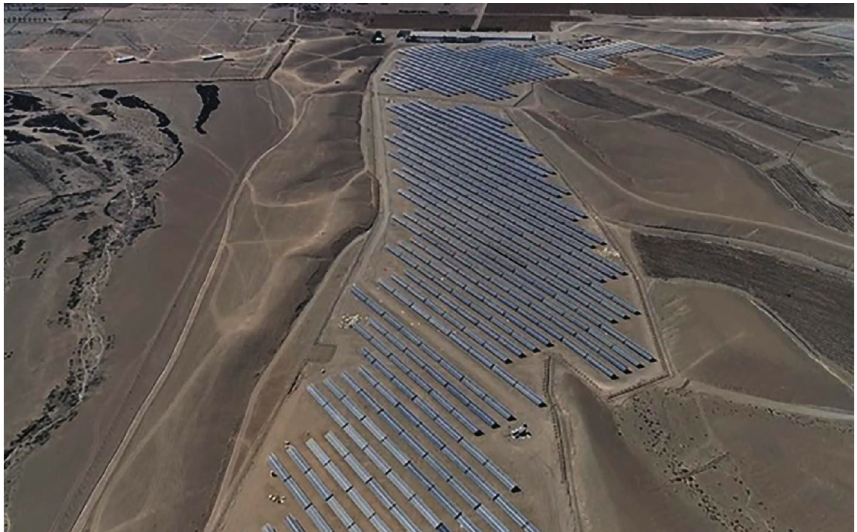
Figure 1: Valle Solar Oeste photovoltaic plant.